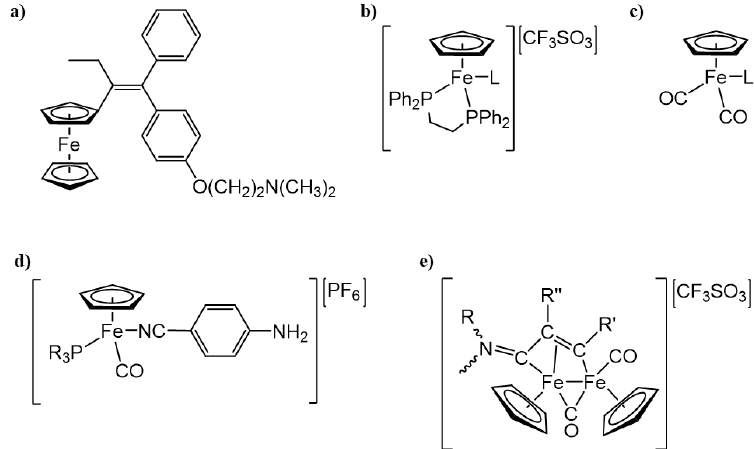
Figure 1. Organometallic iron-based compounds with potential as anticancer agents. ( a ) Ferrocifen; ( b ) L = imidazole or nitrile based ligand; ( c ) L = Cl, Br, I, isothiocyanates; ( d ) PR 3 = phosphane-based ligand; and, ( e ) R = Me, xyl, CH 2 Ph; R’ = Ph, 2-naphthyl, 3-C 6 H 4 OH, 4-C 6 H 4 CO 2 H, 3-thiophenyl, Me, CO 2 Me, 2-pyridyl; R” = H, CO 2 Me, Me, Ph.